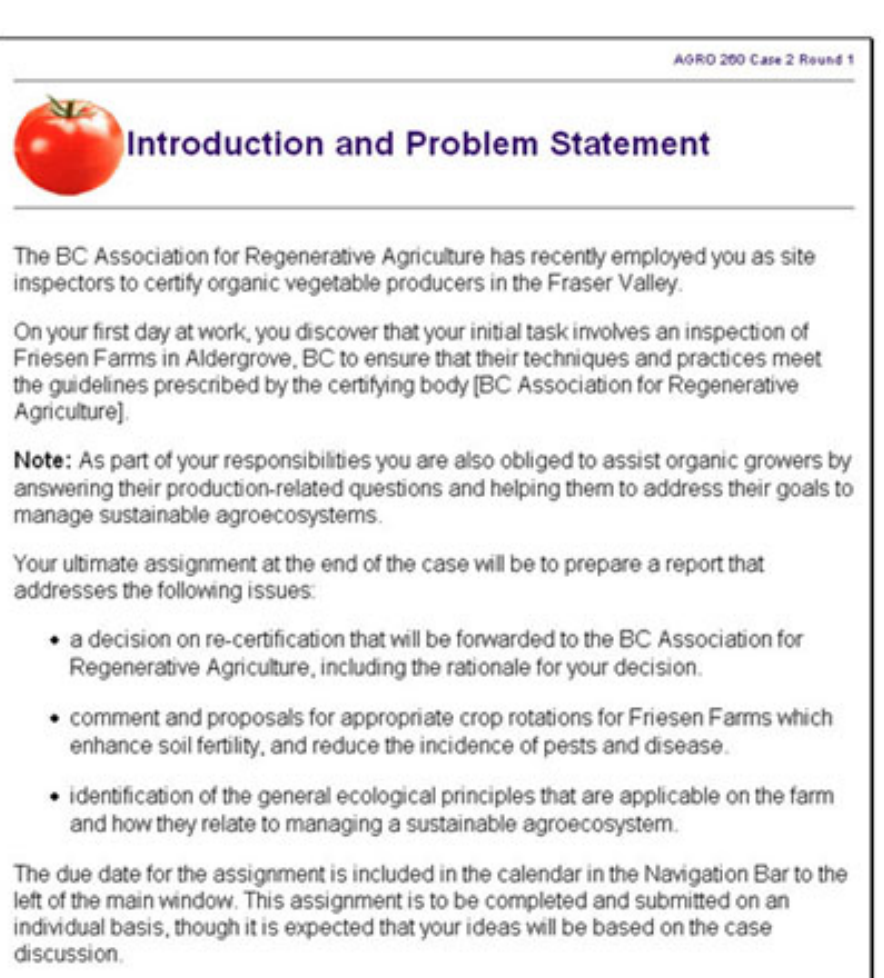
Figure 1. AgroEcology Case 2 problem